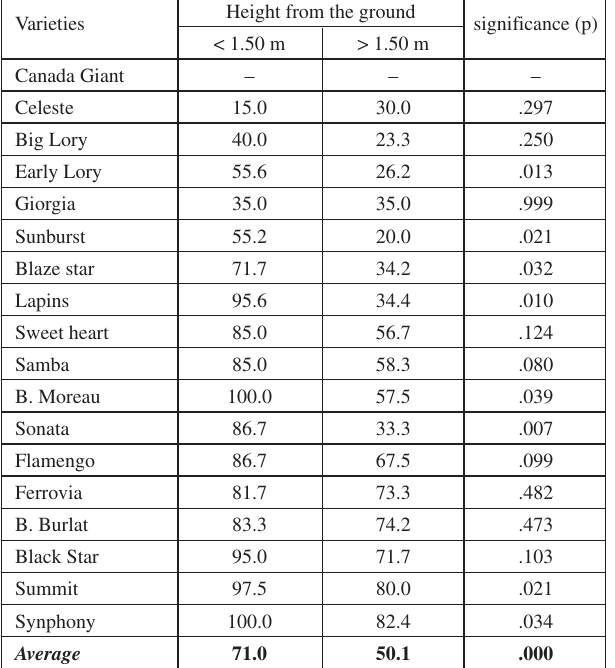
Table 5. Average of flowers percentage destroyed by spring frost, in orchard 2 as related to rootstock and to flowers height from the ground R Varieties Height from the ground significance (p)t Canada Giant